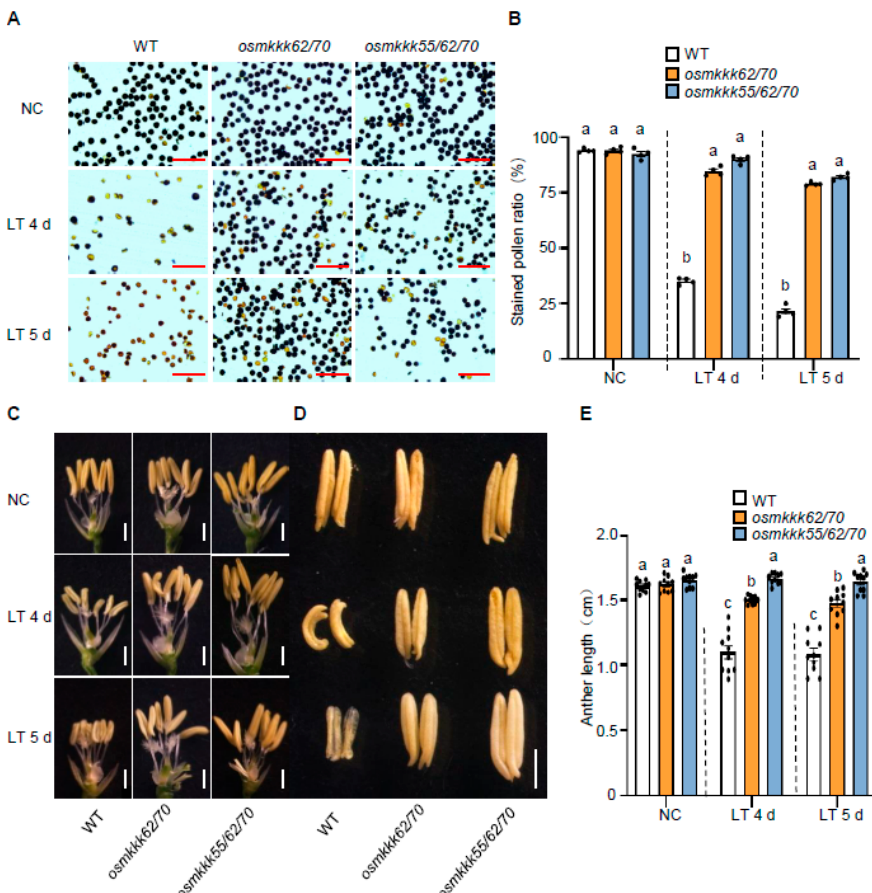
Figure 3. osmkkk62/70 and osmkkk55/62/70 show higher pollen fertility and healthy anthers under low-temperature treatment. ( A ) Representative images of stained pollen from WT, osmkkk62/70 , and osmkkk55/62/70 plants grown under NC, and after LT treatment for 4 or 5 days. The scale bars are 50 µ m. ( B ) Quantification of stained pollen ratio in ( A ). Data are shown as means ± SE (n = 10). ( C , D ) Gross morphology of anthers from WT, osmkkk62/70 , and osmkkk55/62/70 plants grown under NC and exposed to 4 or 5 d of LT treatments. The scale bar in ( C , D ) is 1 cm and 5 mm, respectively. ( E ) Quantification of anther length of WT, osmkkk62/70 , and osmkkk55/62/70 plants grown under NC and exposed to 4 or 5 d of LT treatments. Values are means ± SE (n = 10). Dotted lines were drawn to separate the NC and LT, and the comparison is among different genotypes in the same condition. Each dot represents the result from one biological replicate; error bars indicate means ± SE. Statistically significant differences are indicated by different lowercase letters ( p < 0.05, one-way ANOVA with Tukey’s significant difference